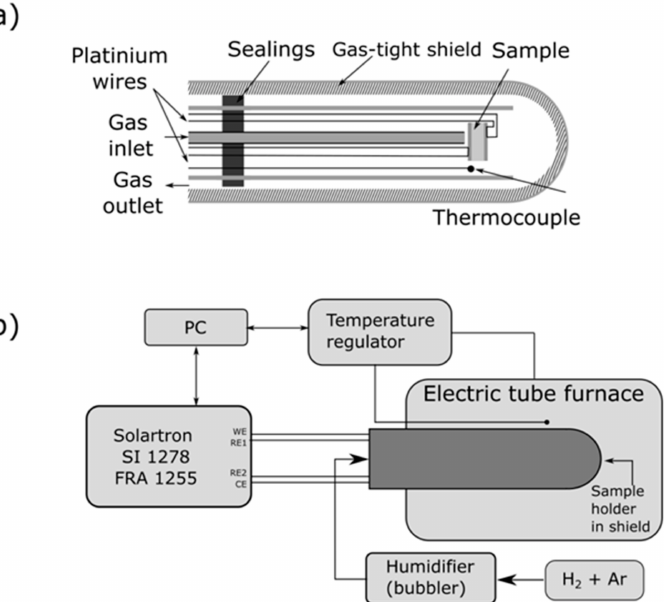
Figure 1. ( a ) Construction of electrical probe for four-wire AC electrical conductivity measurement; ( b ) all of the equipment and apparati used for these experiments.